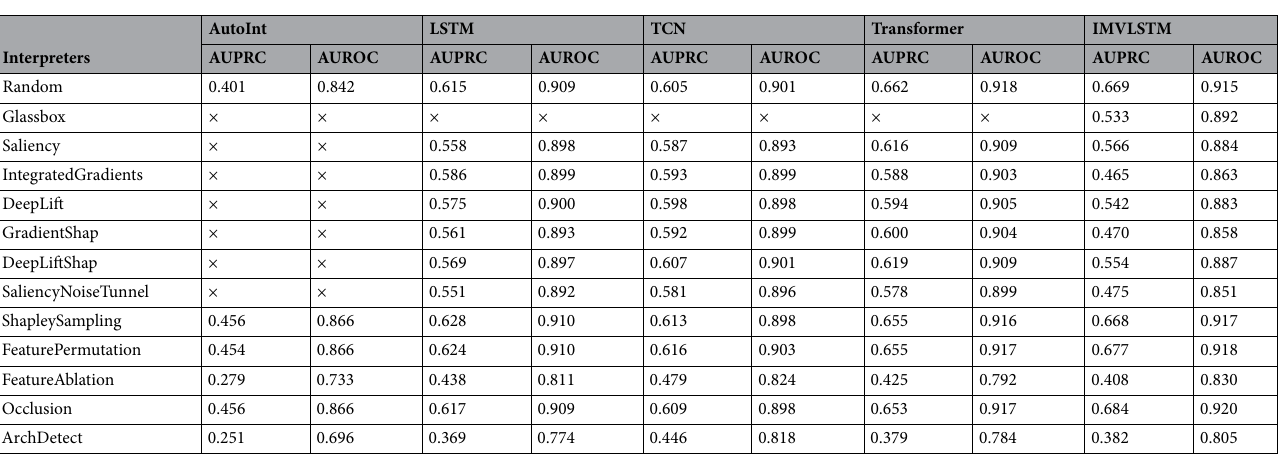
Table 3. Area under the curve (AUC) of interpretability methods for each model and each classification performance metric evaluated using ROAR. AUC is measured for two prediction metrics (AURPC and AUROC) respectively. Lower AUC indicates more rapid prediction performance drop and better feature importance